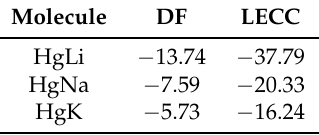
Table 3. The calculated values of E eff (in GV/cm), at the Dirac–Fock (DF) and the LECC levels. Molecule DF LECC